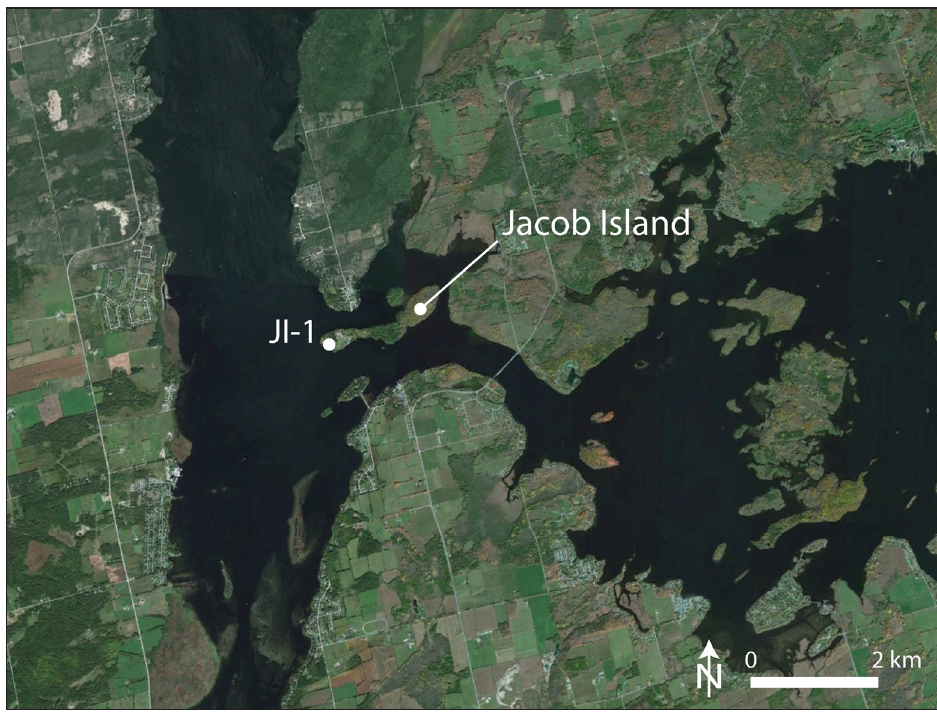
Figure 2: Jacob Island and JI-1. Image copyright DigitalGlobe